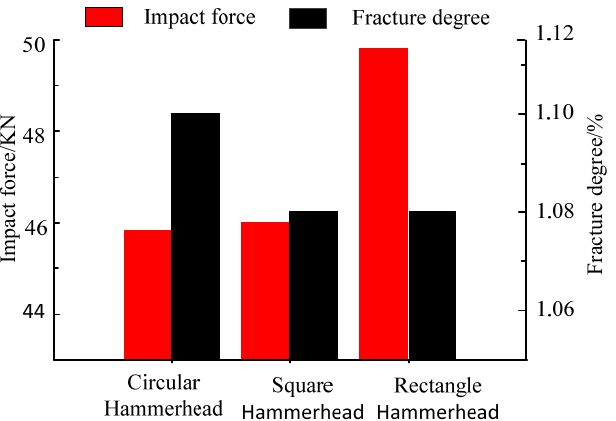
Figure 7. Comparison of impact forces and rupture degrees under different hammer impacts.